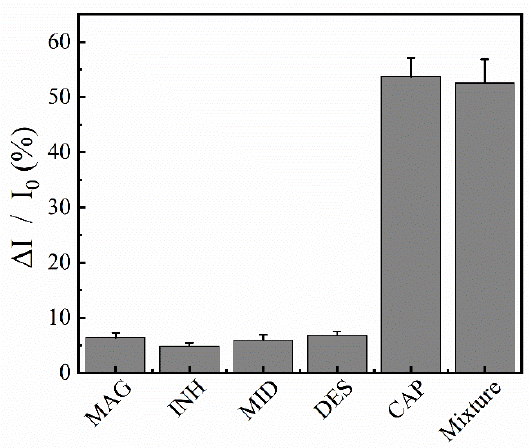
Figure 6. Selectivity studies of aptasensor in existing of 10 nM CAP and 500 nM magnolol (MAG), isoniazid (INH), midecamycin (MID), and diethylstilbestrol